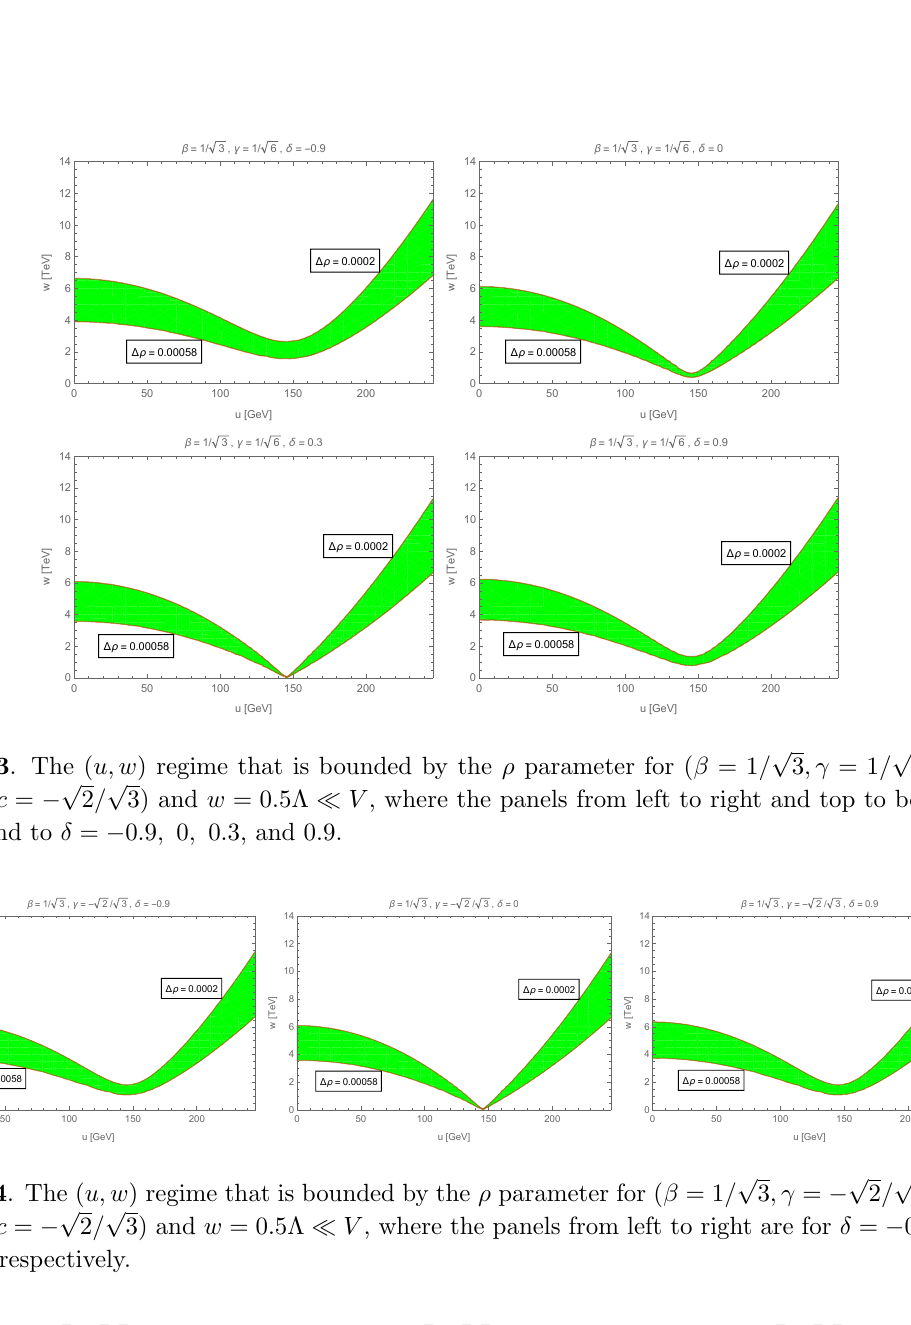
V , where the panels from left to right are for δ = (cid:29)